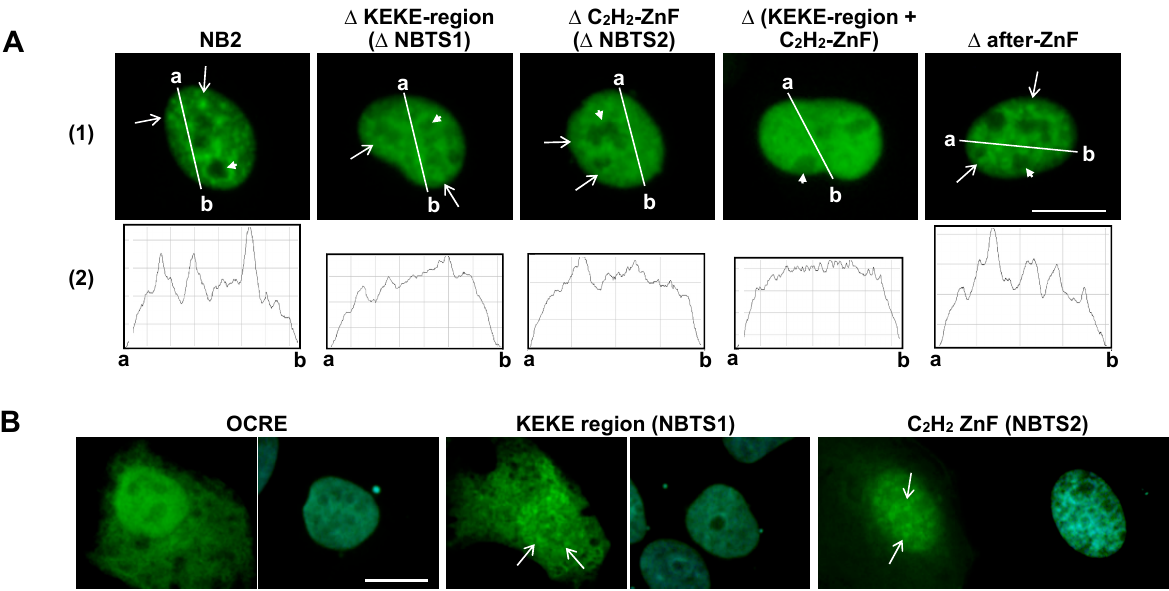
Figure 5. Verification of NBTSs. ( A ) NB-localization of NB2 and its mutants. (1) The KEKE region (aa 524–598), the C 2 H 2 ZnF region (aa 685–703), both the KEKE and C 2 H 2 ZnF regions, or the after-ZnF region (aa 711–742) was deleted from pNB2/EGFP-C3, and constructs were expressed in ARL cells. Green: EGFP. Some S1-1 NBs and nucleoli are indicated by arrows and arrowheads, respectively. (2) Analysis by ImageJ Plot Profile. Nuclear distribution of NB2 and its mutants in the images in (1) was analyzed along indicated lines, drawn to traverse extra-nucleolar nucleoplasm. ( B ) Verification of NB-targeting activity of the KEKE region (NBTS1) and C 2 H 2 ZnF (NBTS2). Sequences encoding the KEKE region (aa 529–590), the C 2 H 2 ZnF (aa 676–711), and the control OCRE region (aa 475–533) were PCR-amplified, ligated to the FLAG-tag in p3xFLAG-Myc-CMV-24, and expressed in ARL cells. Cells were stained with an antibody against FLAG (green), and nuclei were counterstained with 4’,6-diamidino-2-phenylindole (blue). Scale bar: 10 µ